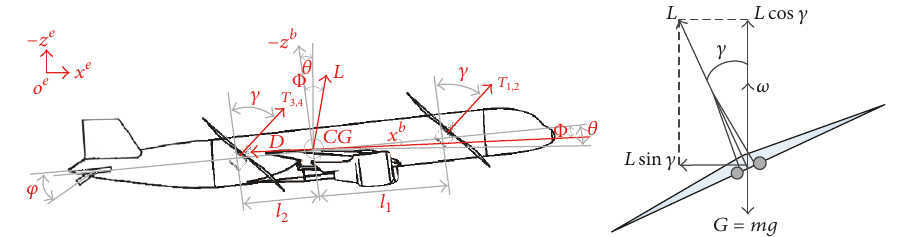
Figure 2: Body scheme showing the forces acting on the